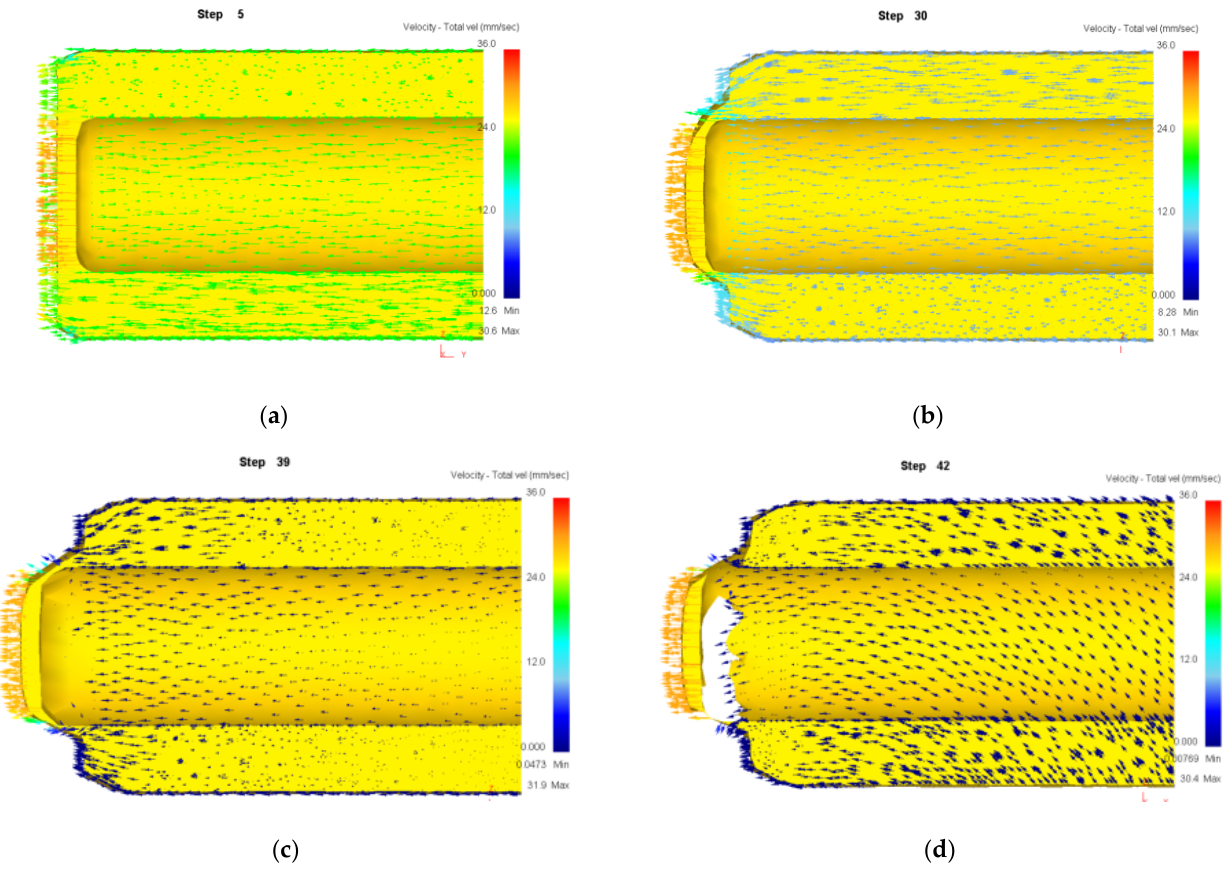
Figure 9. Velocity vector of billet with bottom thickness of 10 mm. ( a ) Step of 5; ( b ) 30; ( c ) 39; ( d ) 42.